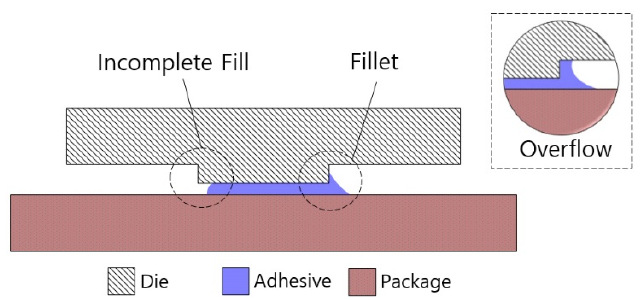
Figure 11. Cross ‐ sectional view of the pillar die attach (not to scale).